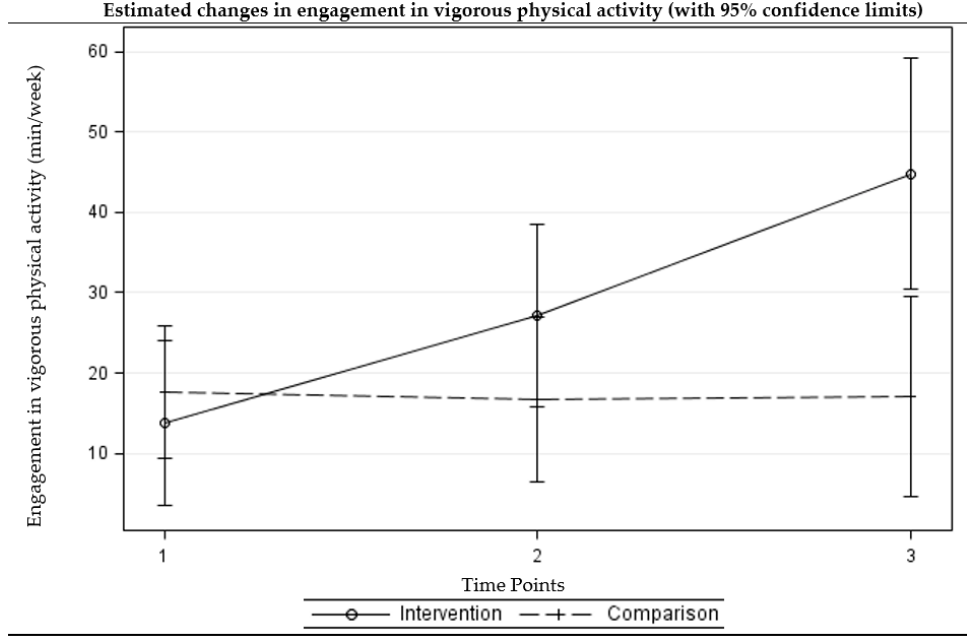
Figure 5. Estimated changes over time in engagement in vigorous physical activities among intervention and comparison groups. (Time points: 1 = baseline, 2 = three ‐ month follow ‐ up, and 3 = six ‐ month follow ‐ up) (Multi ‐ level multivariable mixed ‐ effects linear model).